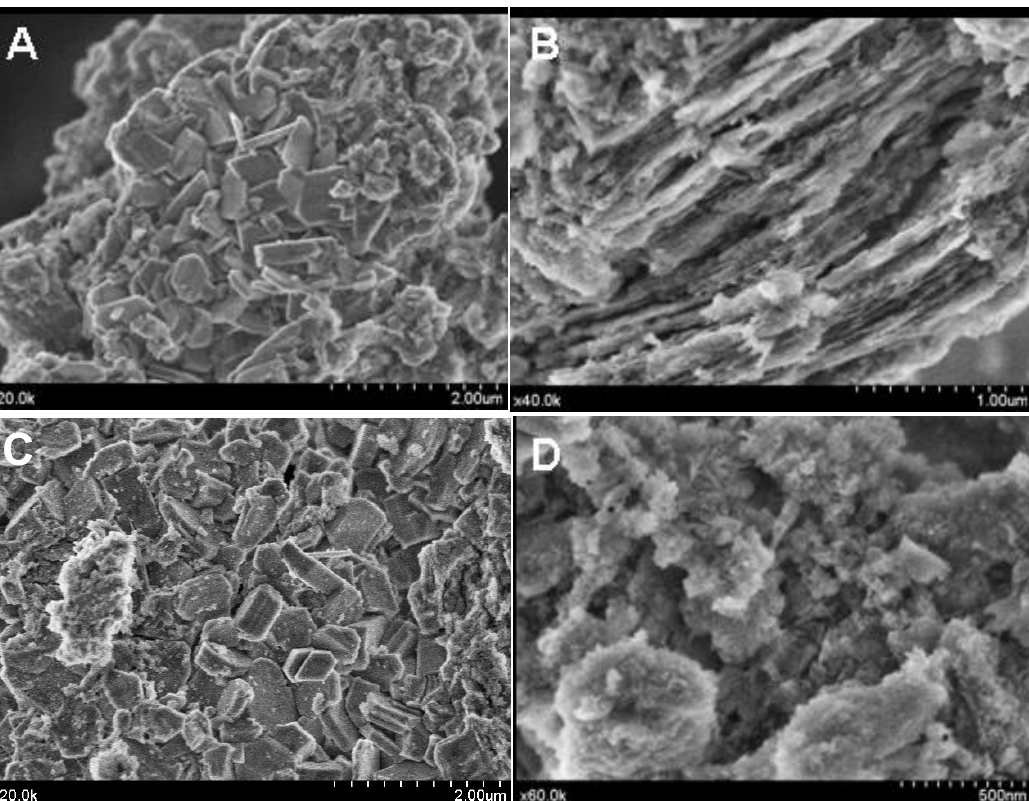
Figure 4. Scanning electron microscopy images of ( A ) γ -Al ( C , D ) 20IL/ γ -Al